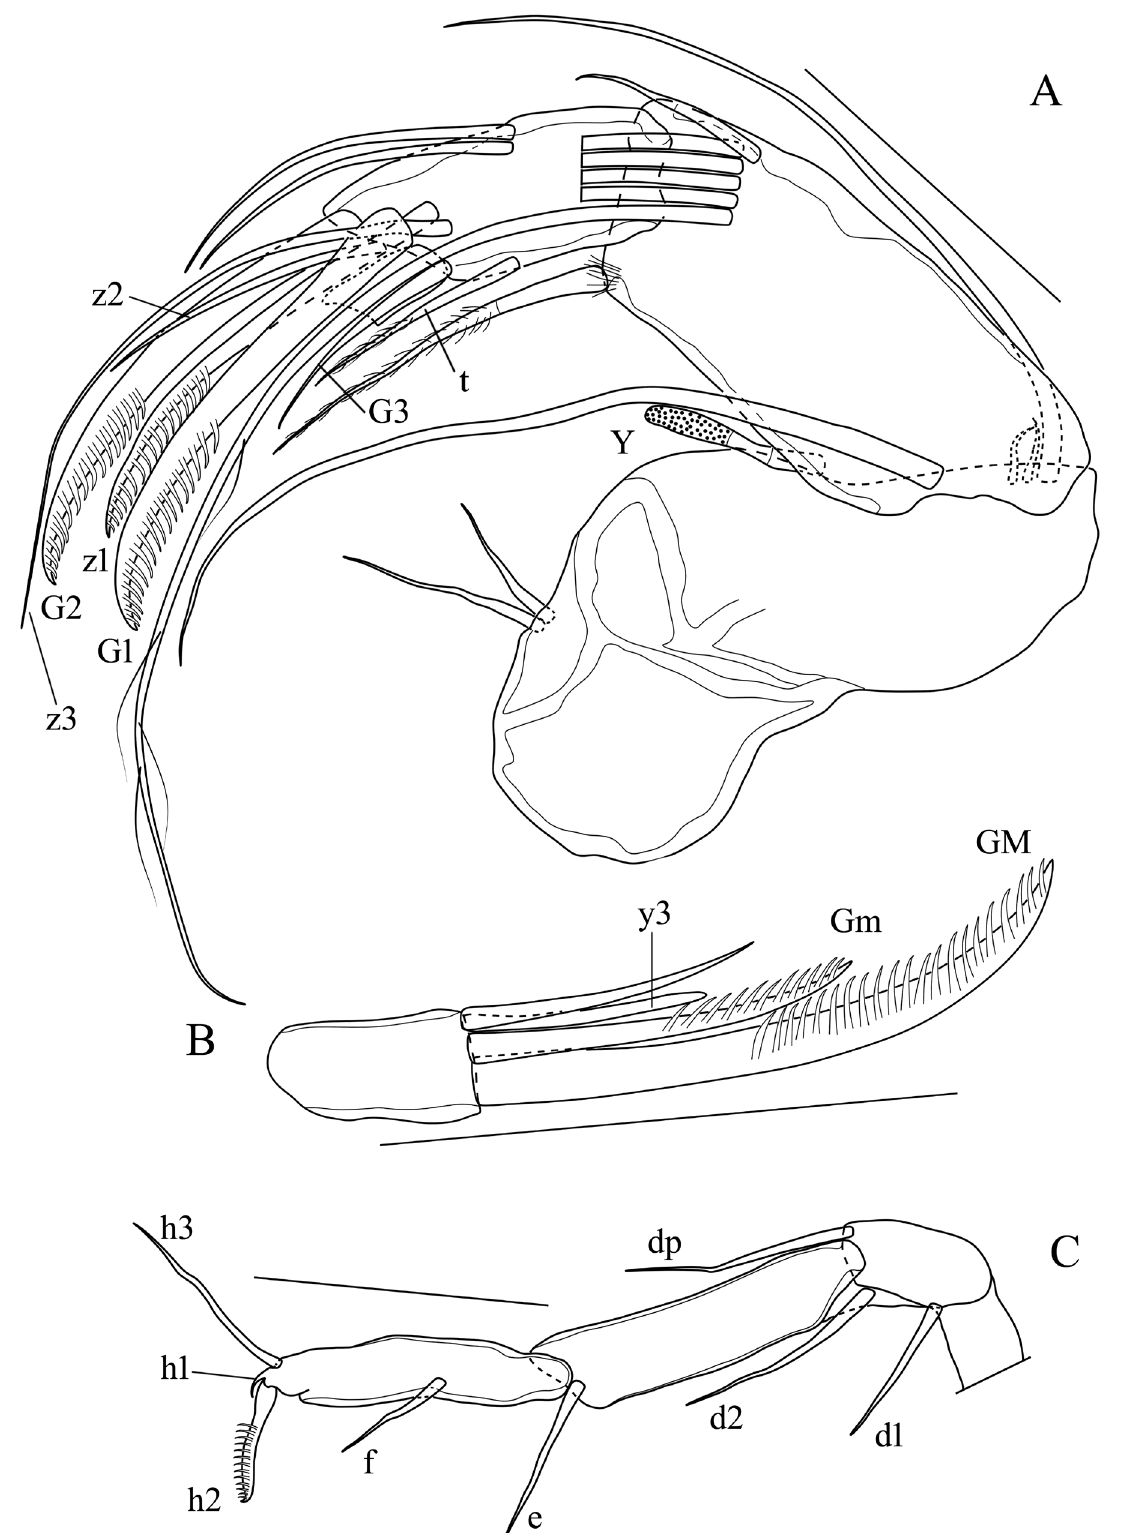
Fig. 14. Brasilodopsis amazonica gen. et sp. nov. from Amazon River floodplain, ♂. A . A2, without the terminal segment (MZUSP 41854). B . A2, terminal segment (MZUSP 41854). C . T3 (MZUSP 41854). Abbreviations: see text and Material and methods. Scale bars: 50